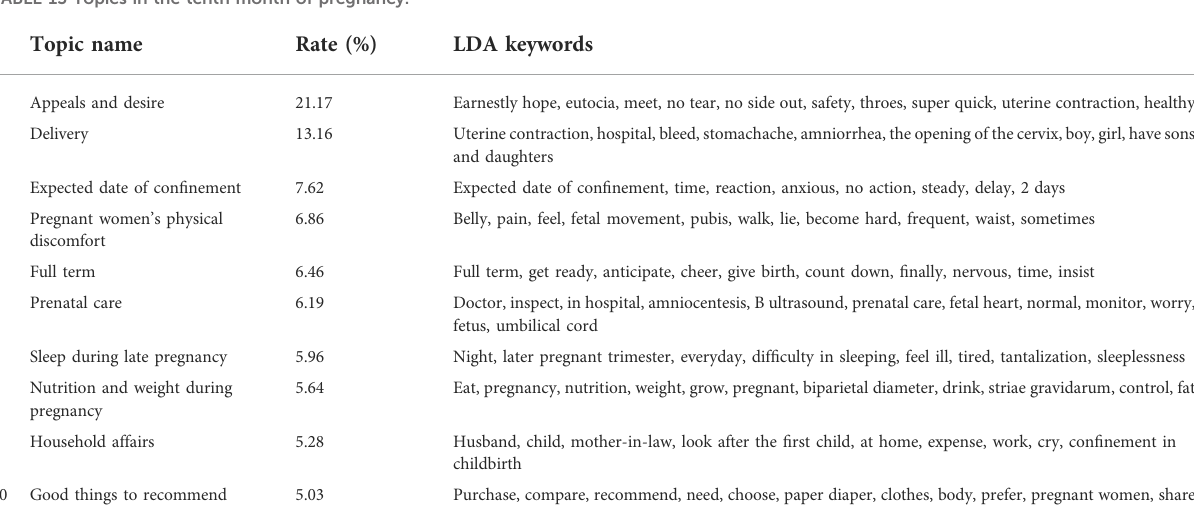
TABLE 13 Topics in the tenth month of